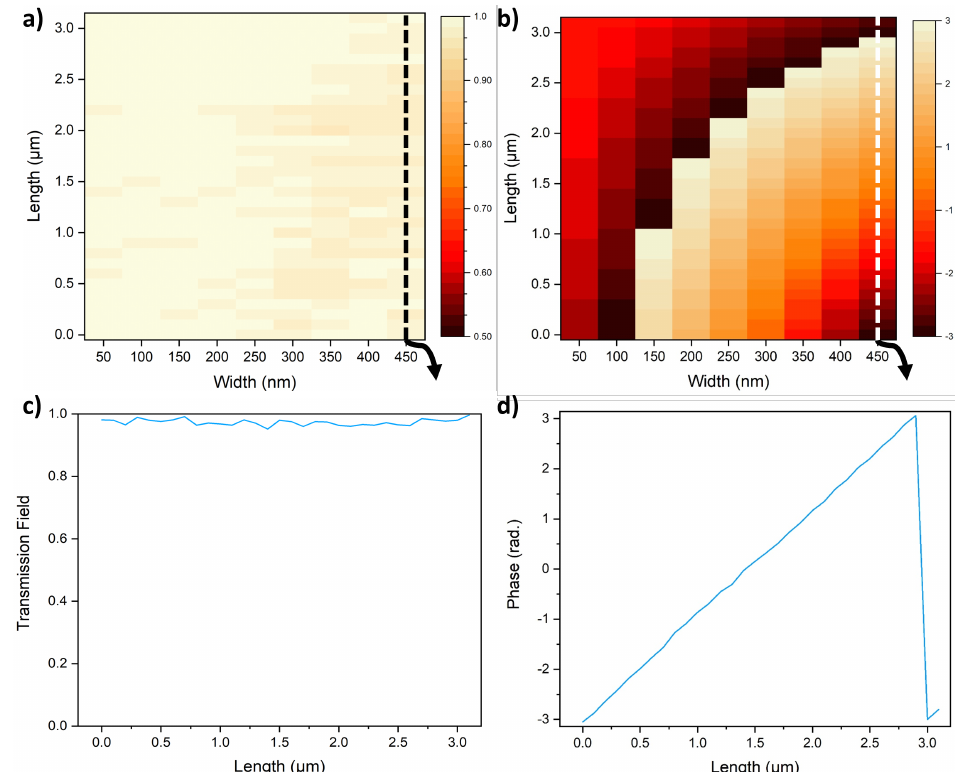
Figure 2. The distribution of transmitted amplitude and phase ( a ) Transmitted amplitude and ( b ) Transmitted phase as a function of length crystalline and the width of the array. ( c ) Transmitted amplitude and ( d ) Transmitted phase as a function of length for a fixed array width of 450